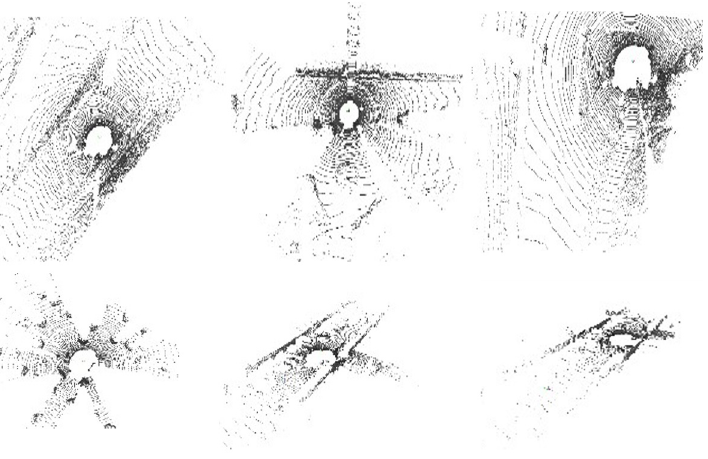
Figure 6. Partial image examples in the dataset.